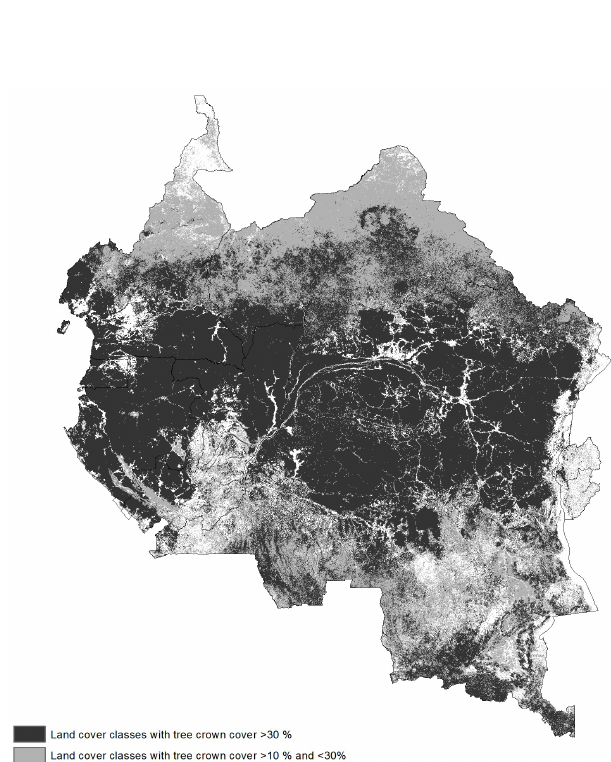
Fig. 13. Spatial representation of the area of the region considered as forest according to the 10% (light and dark grey) or 30% (dark gray) tree crown cover threshold forest definition in the framework of the REDD. Land cover classes with a tree crown cover > 30% are classes 1, 2, 3, 4, 5, 6 and 8. Land cover classes with a tree crown cover > 10% are classes 1, 2, 3, 4, 5, 6, 8, 9 and 10.